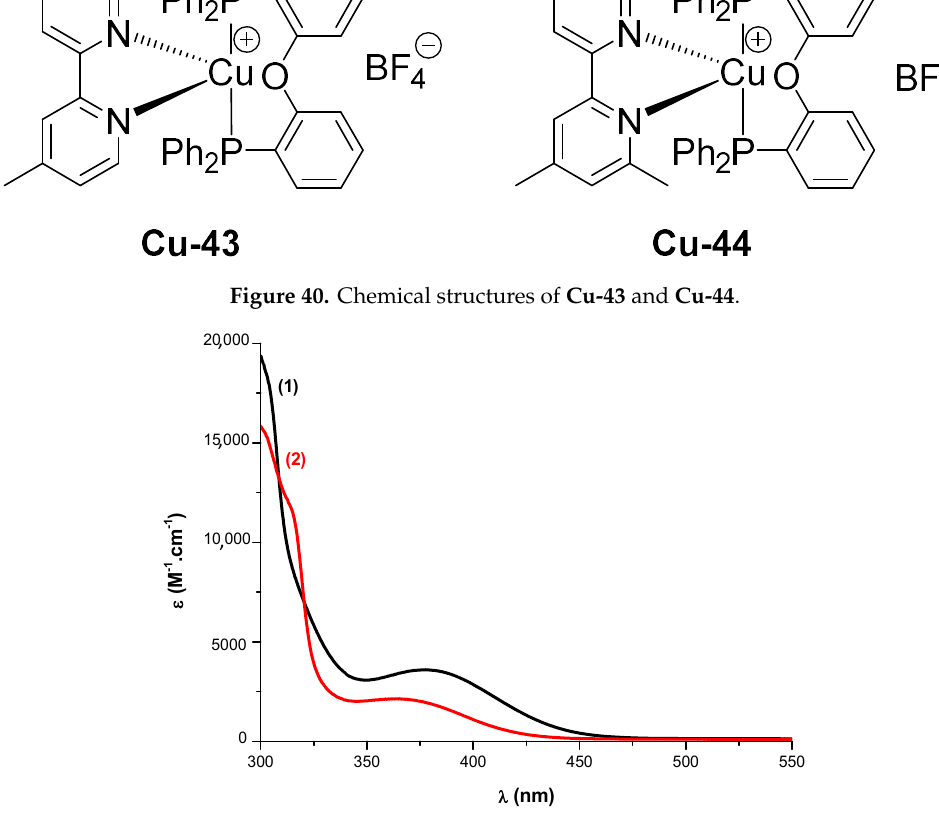
Figure 41. UV–visible absorption spectra of (1) Cu-43 and (2) Cu-44 in dichloromethane. Reproduced with permission from the authors of [138]. Copyright 2018 The Royal Society of Chemistry.